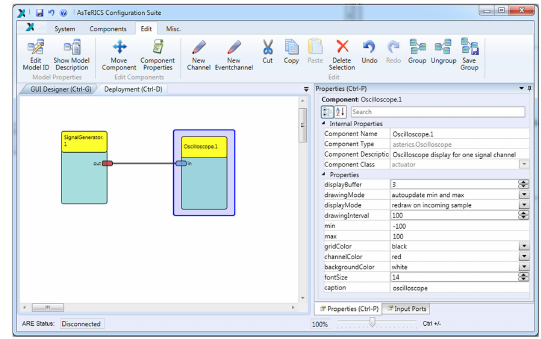
Figura 4. AsTeRICS configuration suite. Source: Ossmann et al. (2014).